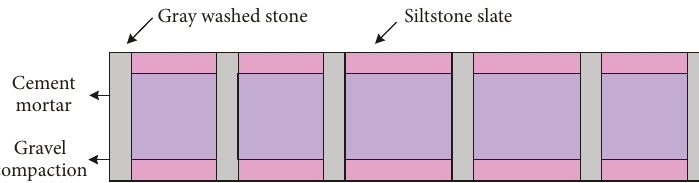
Figure 6: Rustic material use in roadways.